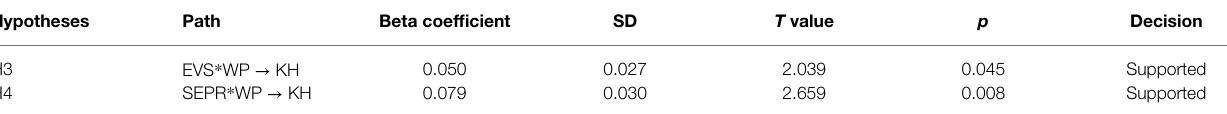
TABLE 6 | Moderation effects.